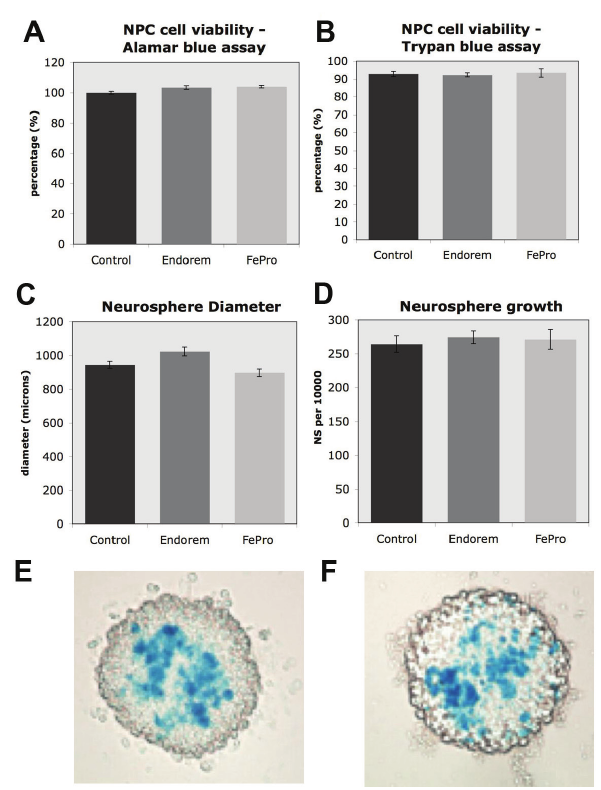
Figure 2. Effect of FePro- and Endorem-labelling on NPC viability and growth. A , Alamar Blue assay. No significant difference in NPC metabolism (F=0.736, p=0.49) is observed. B , Trypan Blue assay. No significant difference in cell survival (F=0.106, p=0.901) is observed. C , Neurosphere diameter. Diameter (µm) of Endorem- labelled neurospheres is significantly different from control unlabelled neurospheres (F=7.497; p<0.05). D , Neurosphere forming ability. No significant difference in neurosphere formation per 1000 cells (F=0.184; p=0.833) is observed. E , F . Prussian Blue stain for iron in Endorem (G) and FePro (H) labelled neurospheres after 7 days in culture.